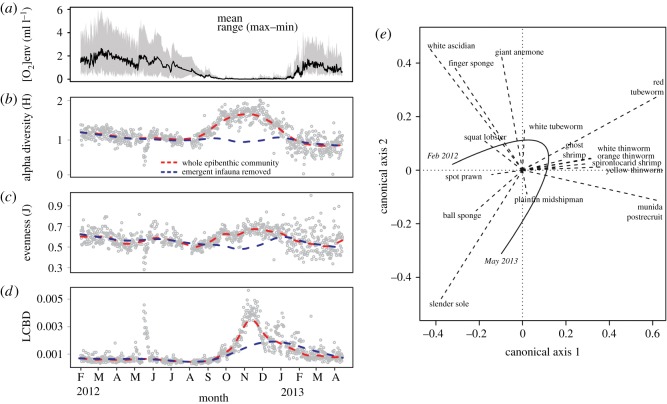
Compositional heterogeneity in seasonal hypoxia. (a) Environmental oxygen data ([O2]env) are summarized from per minute data for the 12-h interval before each sampling time point from February 2012 to March 2013. The annual hypoxia cycle is characterized by relatively higher average [O2]env and variability before and after the onset of severe hypoxia ([O2]env mean < 0.5 ml l−1). Temporal changes in (b) alpha diversity (Hln′), (c) species evenness (J) and (d) local contributions to beta diversity (LCBD) during seasonal hypoxia. Dashed lines are smoothing curves through the sampling time points (circles) that illustrate general trends of the epibenthic community with the emergent infauna included (red) or excluded (blue). May 2012 peaks in alpha diversity, evenness and LCBD were a result of a mass migration of squat lobster (figure 2b). (e) Ordination plot of the species (dashed lines) relationships to time (curved line with the start and end dates) shows the sequential importance of species in driving temporal beta diversity. Species clustered near the origin (0,0) were removed to improve clarity. Slender sole are strongly correlated with the beginning and end of the time series. Spot prawn are associated only with the beginning of the time series (vector points towards start) because they do not return before the end of the observation period.